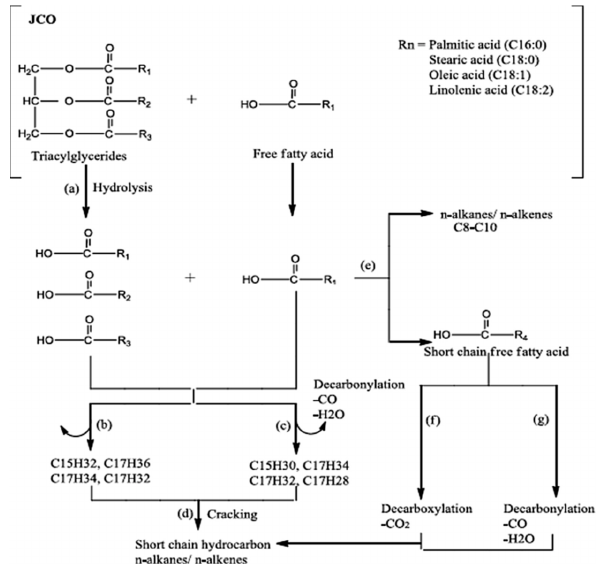
Figure 4. Deoxygenation reaction route for diesel production. Adapted with permission from Ref. [177]. During the decarbonylation process (C 17 H 28 ), FFA is altered to unsaturated n-hepta- decene and n-pentadecane. This transformation includes monounsaturated (C 15 H 30 ,